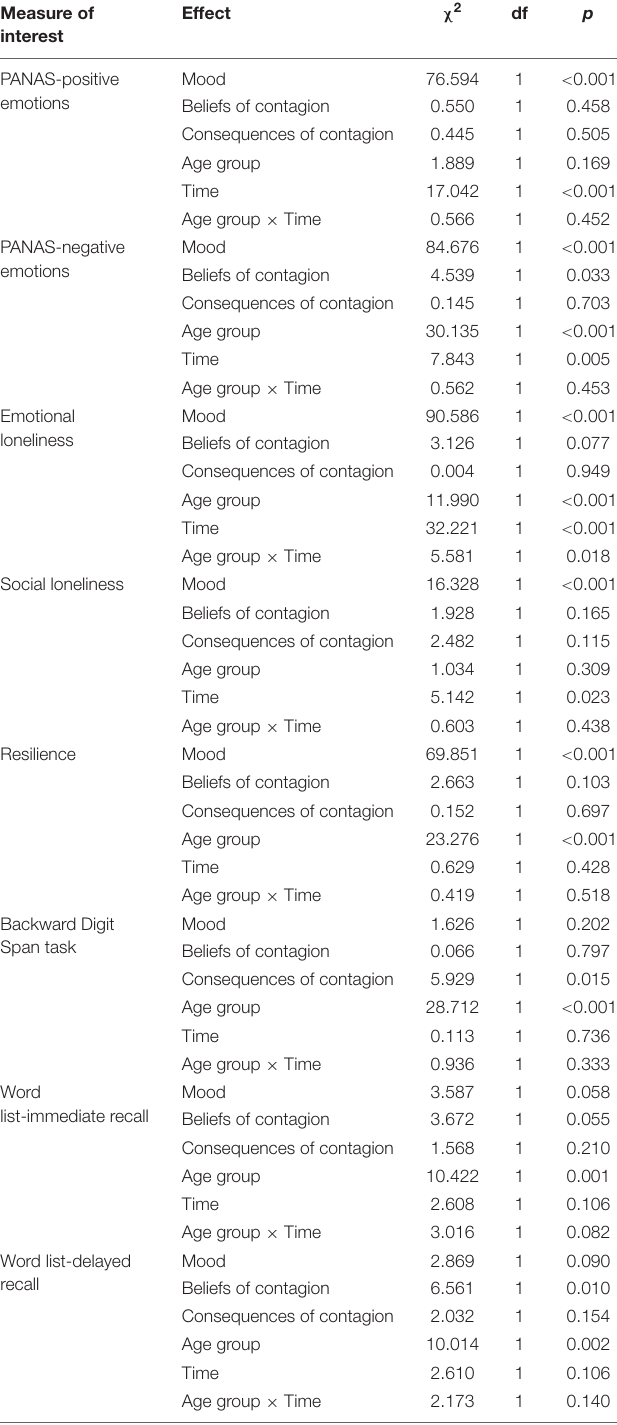
TABLE 2 | Results of the linear mixed-effects models including mood and beliefs and consequences of contagion scales as covariates. Measure of